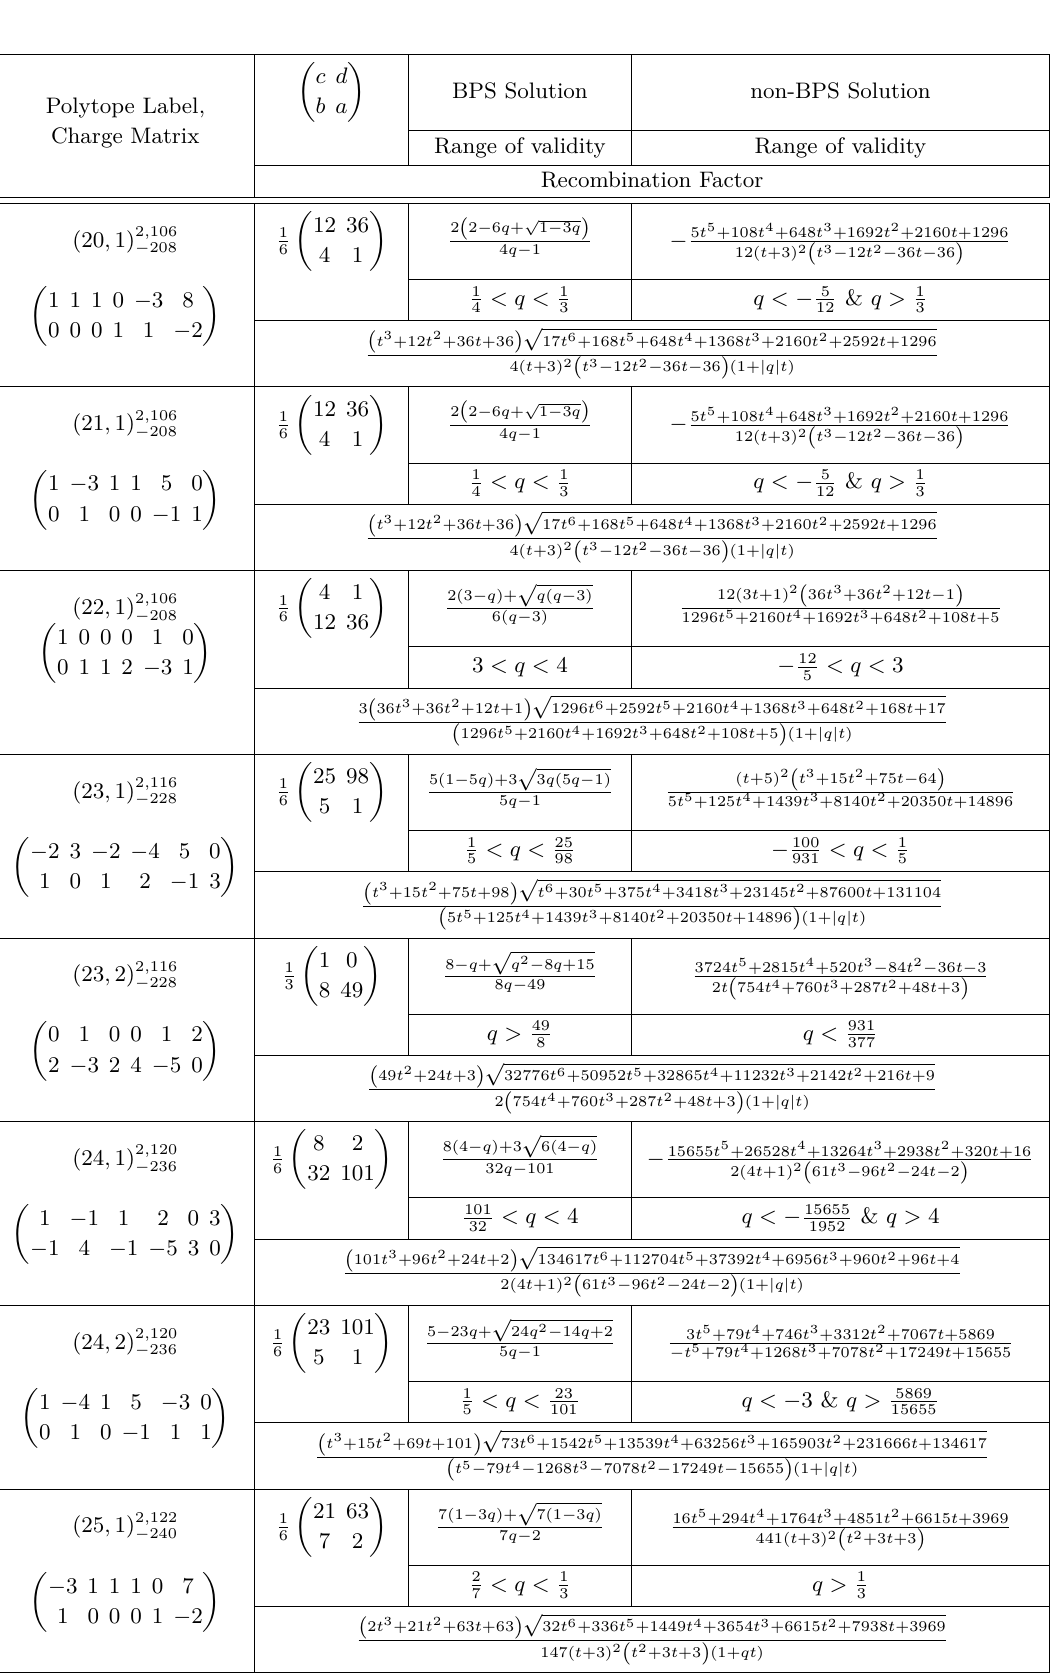
Table 6 . BPS and non-BPS extremal black holes in one-modulus THCY models,